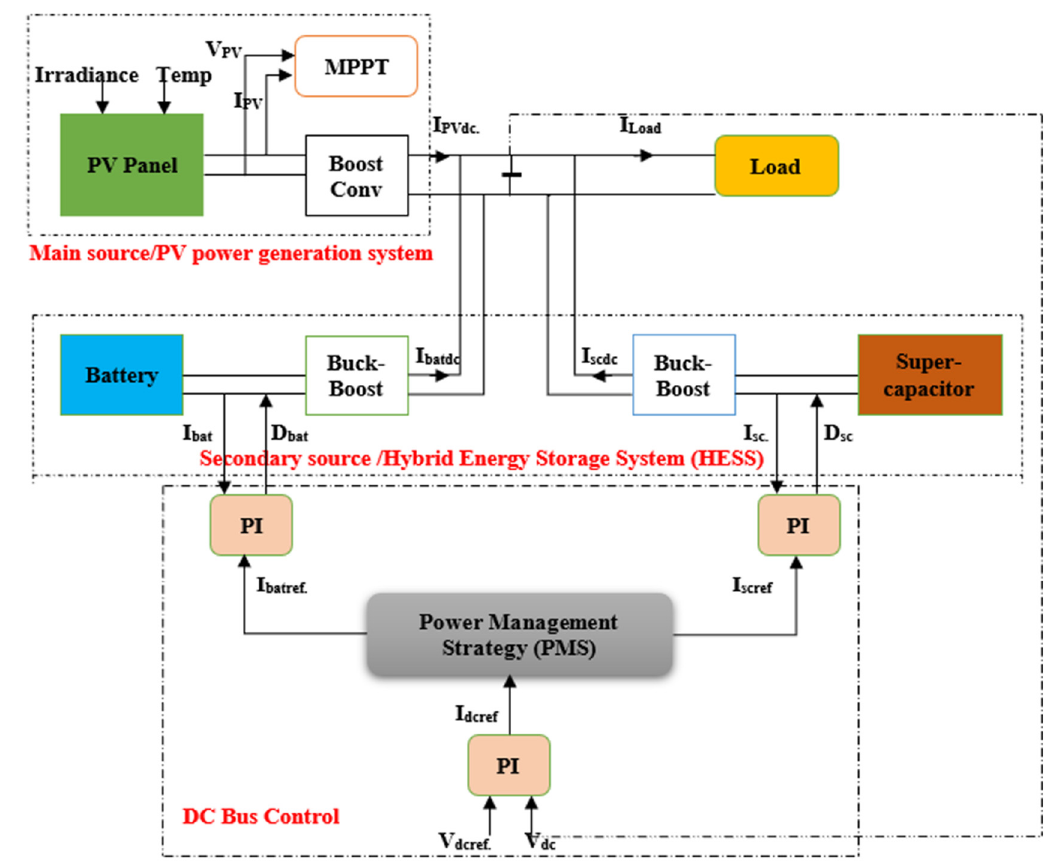
Figure 1. Schematic diagram of the PV system with the energy storage devices.